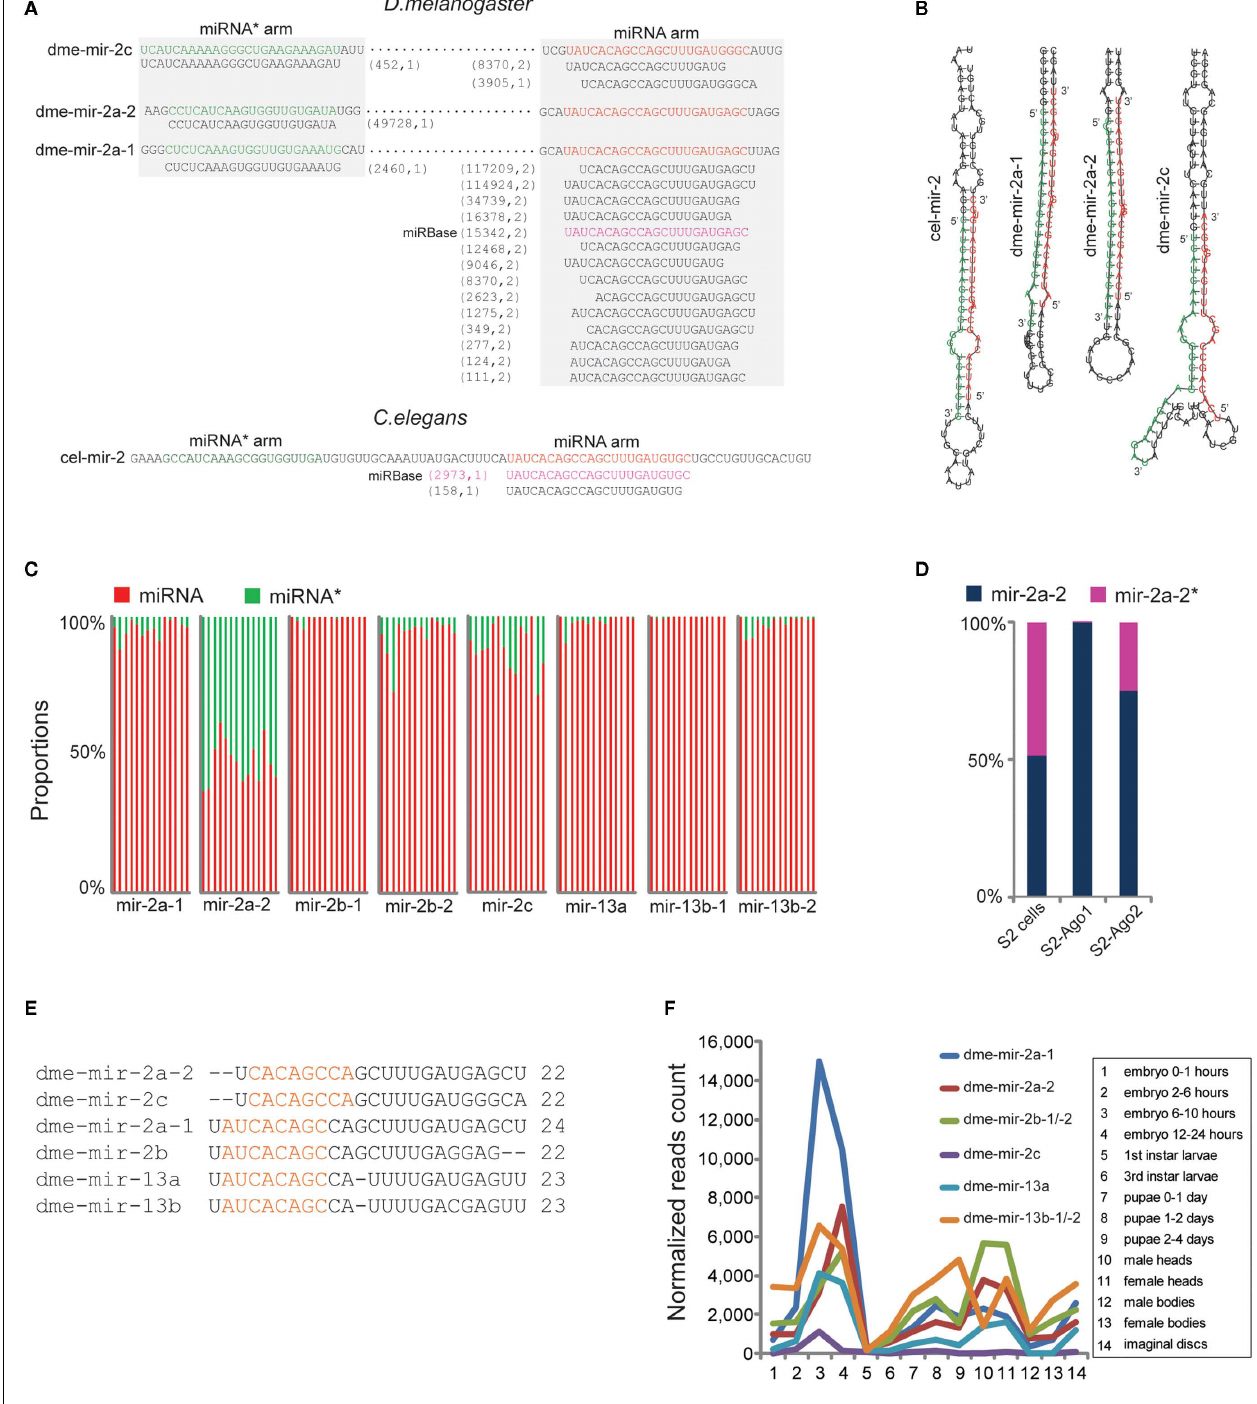
FIGURE 3 | Correction of dme-miR-2 family needs manual inspection of their miRNA/miRNA ∗ duplexes. (A) The dme-mir-2a-1, dme-mir-2a-2, and dme-mir-c possess identical miRNA arms, on which the smRNA-seq reads were multiply mapped.The two numbers in the brackets are the count of smRNA-seq reads and the count of mapped locations in the genome for each isoform. (B) For the hairpin structures, we found that the 24-nt mir-2a isoform paired with mir-2a-1*, the 22-nt mir-2a isoform paired with mir-2a-2*, and 22-nt mir-2c isoform paired with mir-2c ∗ to form the correct miRNA/miRNA ∗